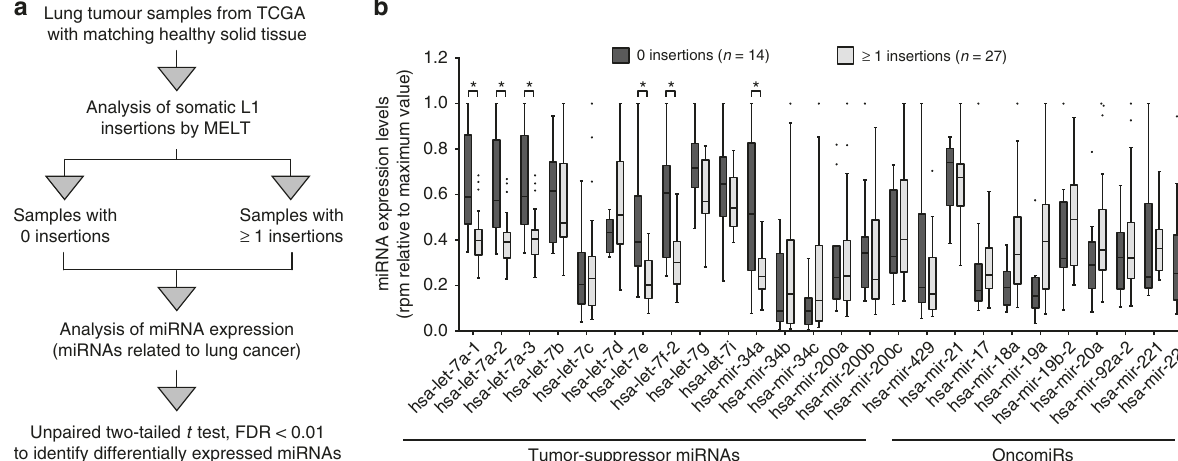
Fig. 1 Let-7 and miR-34a are downregulated in lung tumor samples with tumor-speci fi c L1 insertions. a Schematic representation of the bioinformatic analysis used to identify differentially expressed miRNAs in lung cancer samples with or without tumor-speci fi c L1 insertions. b A graph plot representing the expression levels of miRNAs previously associated with lung cancer 50 in lung tumor samples without (dark gray, N = 14) and with (light gray, N = 27) tumor-speci fi c L1 insertions identi fi ed by MELT. Differentially expressed miRNAs are marked with * and were identi fi ed applying an unpaired two-tailed t test adjusted by FDR < 0.01. To enable the representation of all miRNAs in one graph, expression in reads per million (rpm) was relative to the maximum value of each miRNA in each case. Source data are provided as a Source Data fi le. Whiskers were calculated using the Tukey method. Individual black dots represent outliers. Boxes extend from 25th to 75th percentiles, and lines in the middle of the boxes represent the